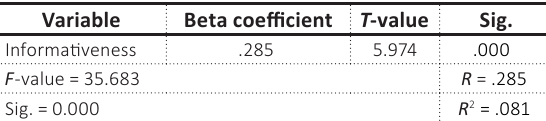
Table 14. Simple linear regression for testing the fourth